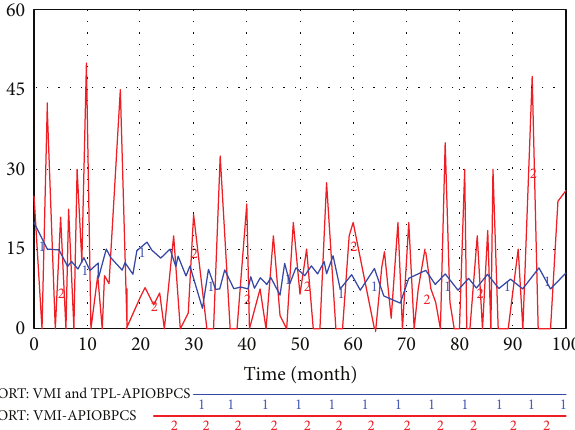
Figure 20: Service levels in the VMI&TPL integrated operation mode. Figure 21: Fluctuation diagram of suppliers’ productivity.